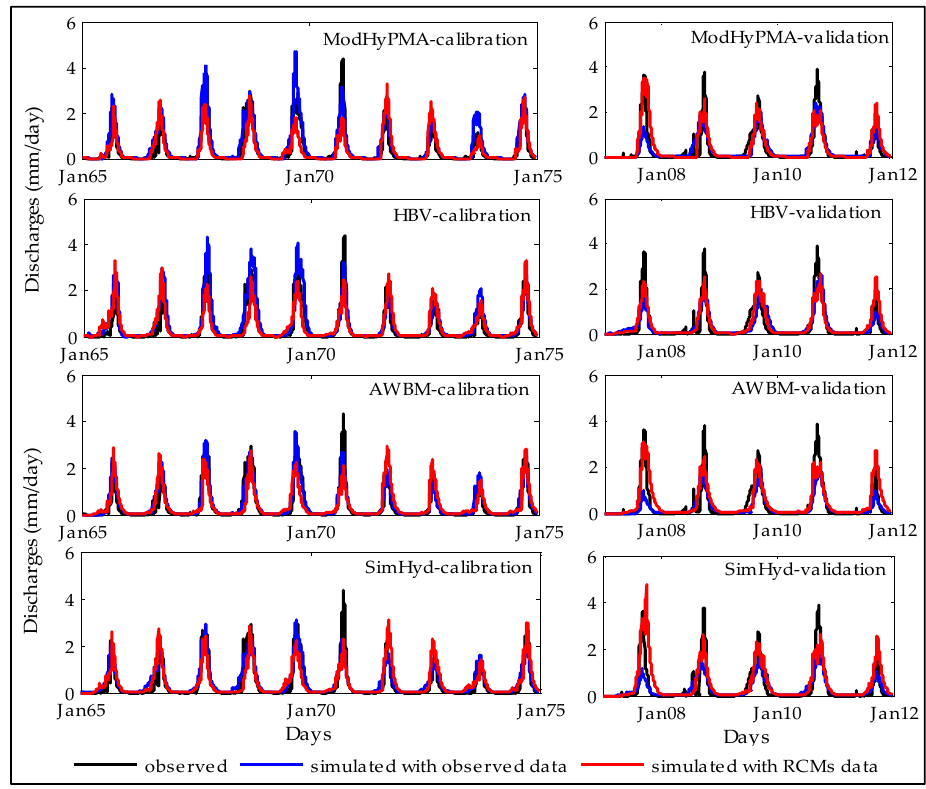
Figure 7. Hydrographs of observed and simulated discharge. Table 6. Performances of hydrological models in calibration and validation period.